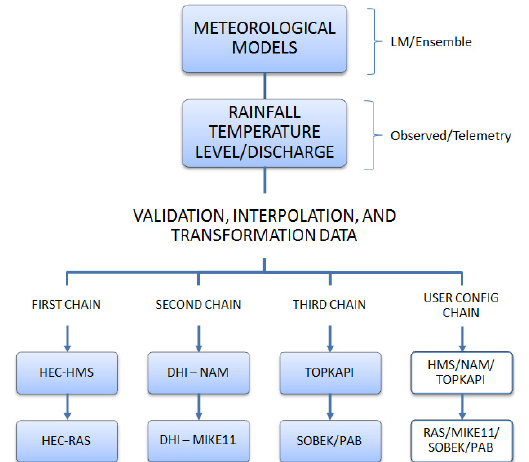
Figure 5. Conceptual model of the Flood Early-Warning System